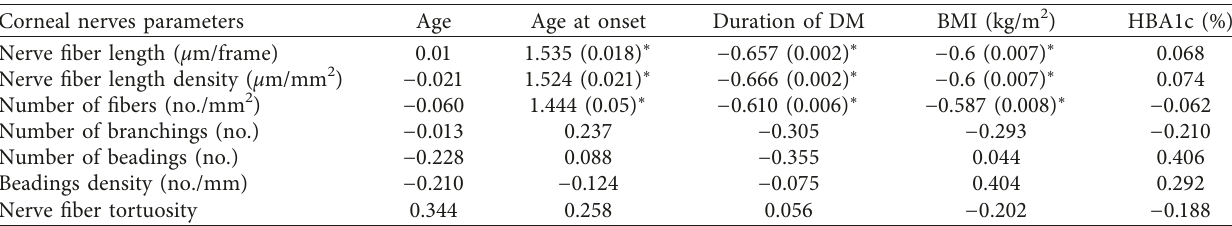
Table 3: Correlation r ( P < 0 . 05) of corneal parameters in the T1DM group with clinical and metabolic data. Corneal nerves parameters